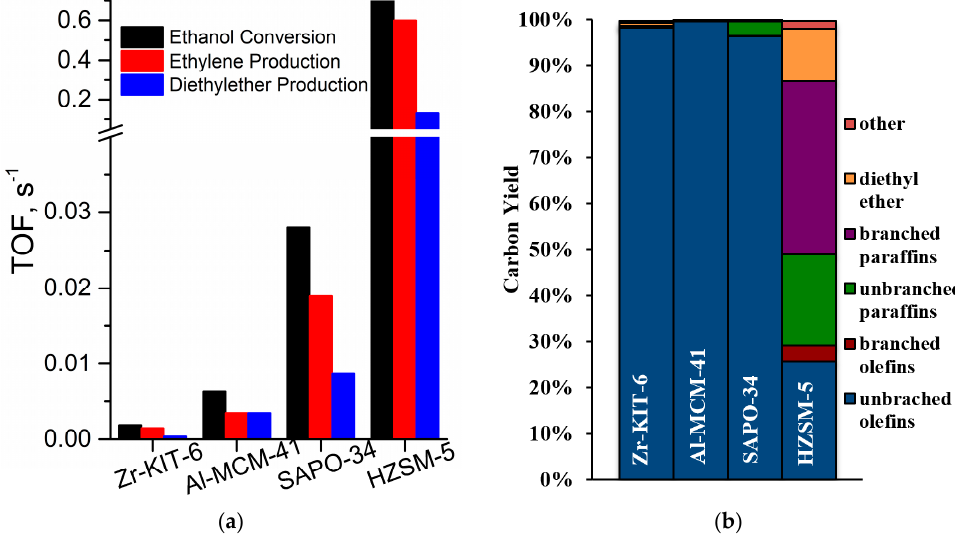
Figure 5. ( a ) TOFs for ethanol conversion and dehydration product yields at 300 °C; and ( b ) carbon yield from mixed alcohol dehydration experiments with the ethanol-rich mixed alcohol feed at 350 °C. ‘Other’ products are carbon monoxide, carbon dioxide, propanal, and methanol. Data represent the average of replicate data points at WHSV = 0.32 h − 1